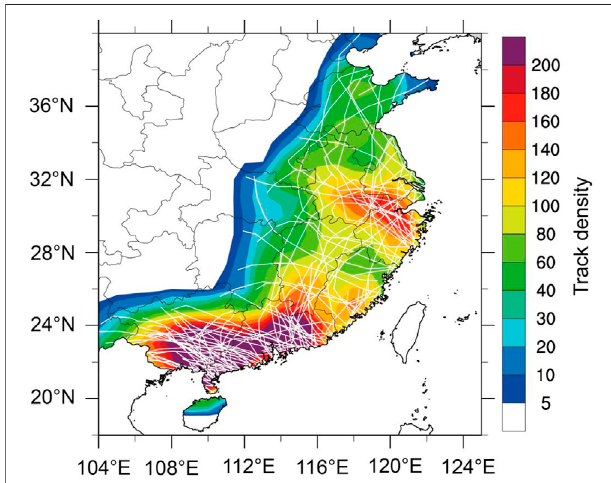
FIGURE 1 | Track density (shaded) of landfalling TCs. The white lines represent the tracks of landfalling TCs.